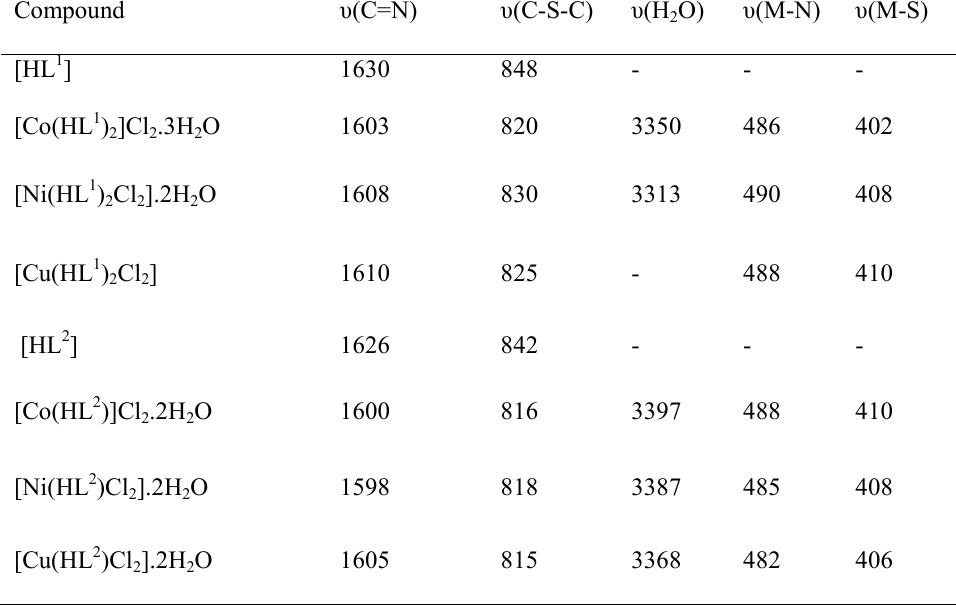
Table 2. IR bands of Schiff base ligands and their